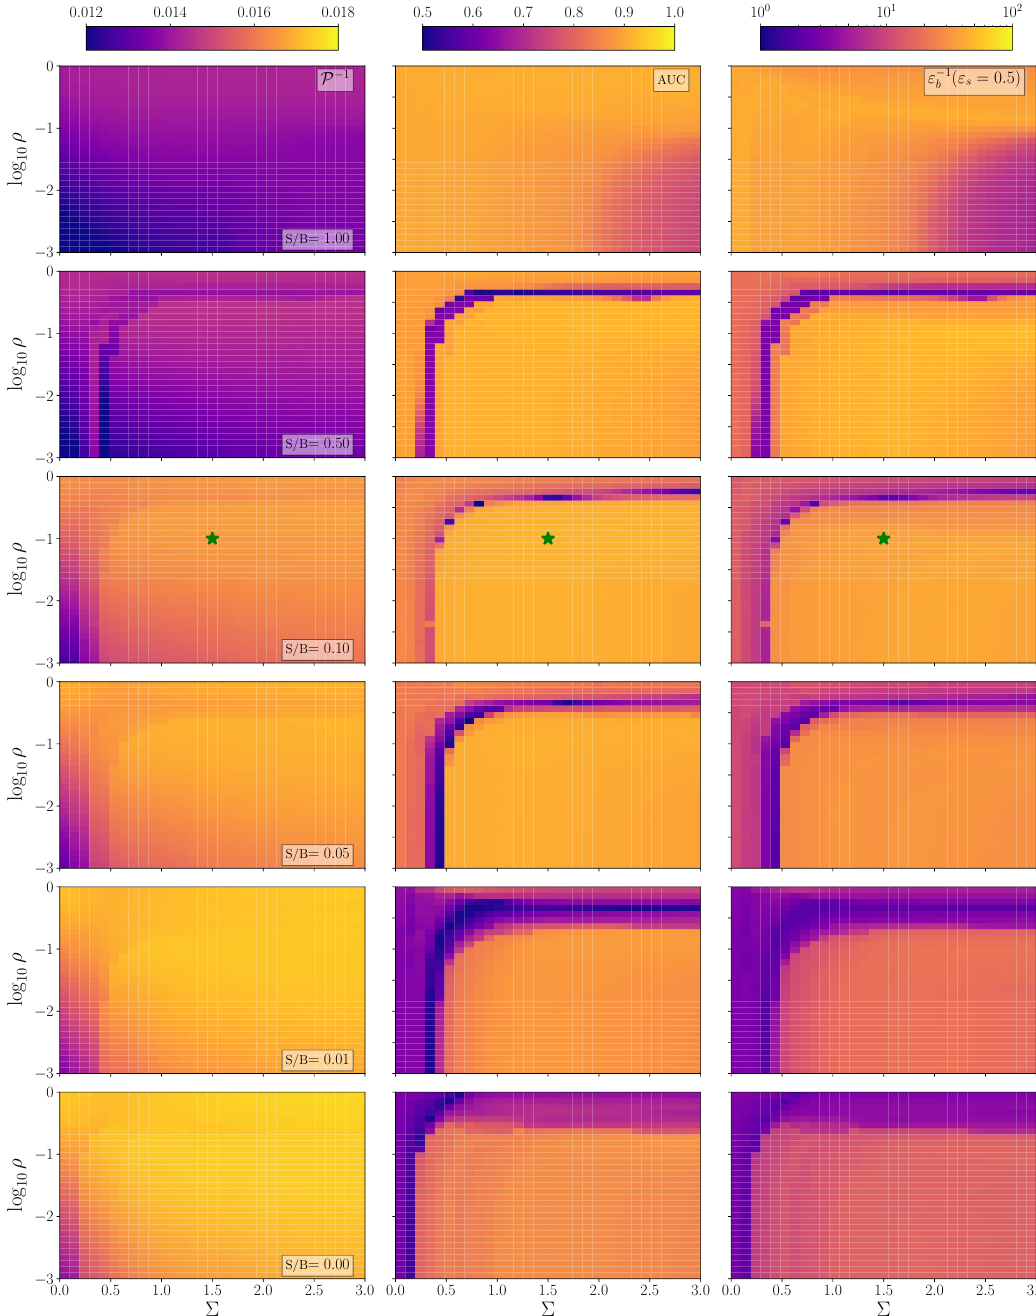
Figure 20 . Results of LDA models in the ( (cid:26); (cid:6)) parameter-space trained on samples of mixed t (cid:22) t and QCD events using mass basis observables m 0 and m 1 =m 0 , with di(cid:11)erent S/B ratios (one per row). Each row contains plots of perplexity, AUC, and inverse mis-tag rate at (cid:12)xed e(cid:14)ciency (see text for details). The green star indicates a maximum perplexity point.